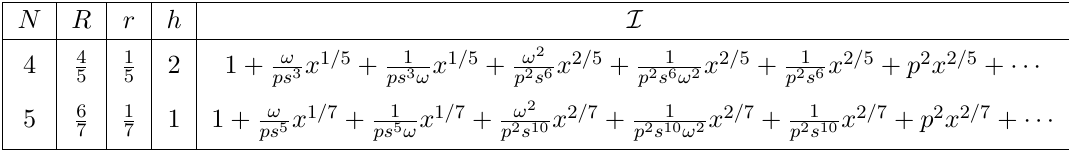
Table 8 . Computation of the superconformal index for di(cid:11)erent values of N up to order O In the last column we report the (cid:12)rst terms of the